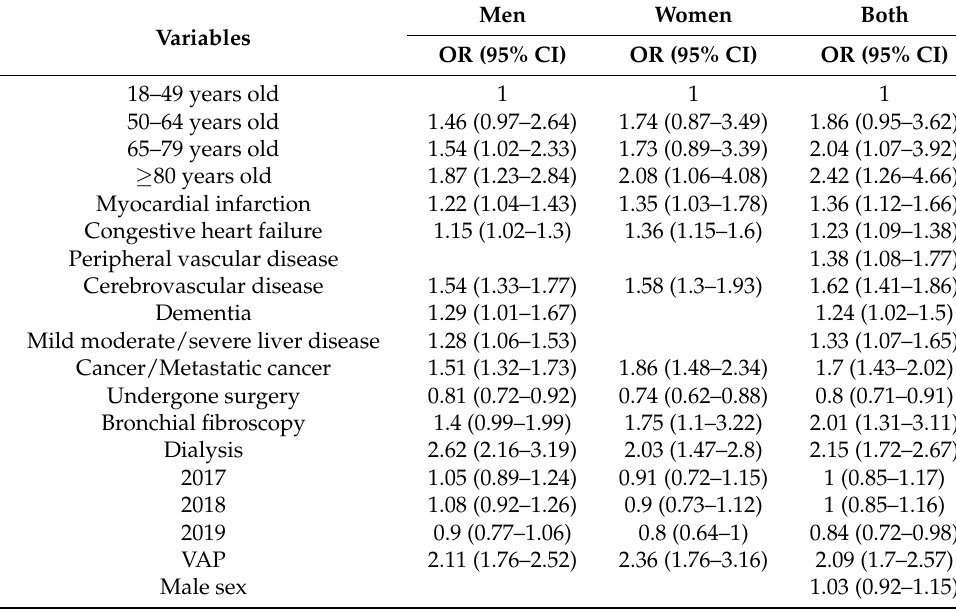
Table 5. Multivariable analysis of factors associated with in-hospital mortality who developed hospital-acquired pneumonia (HAP) among T2DM patients according to sex. Men Women Both Variables OR (95% CI) OR (95%